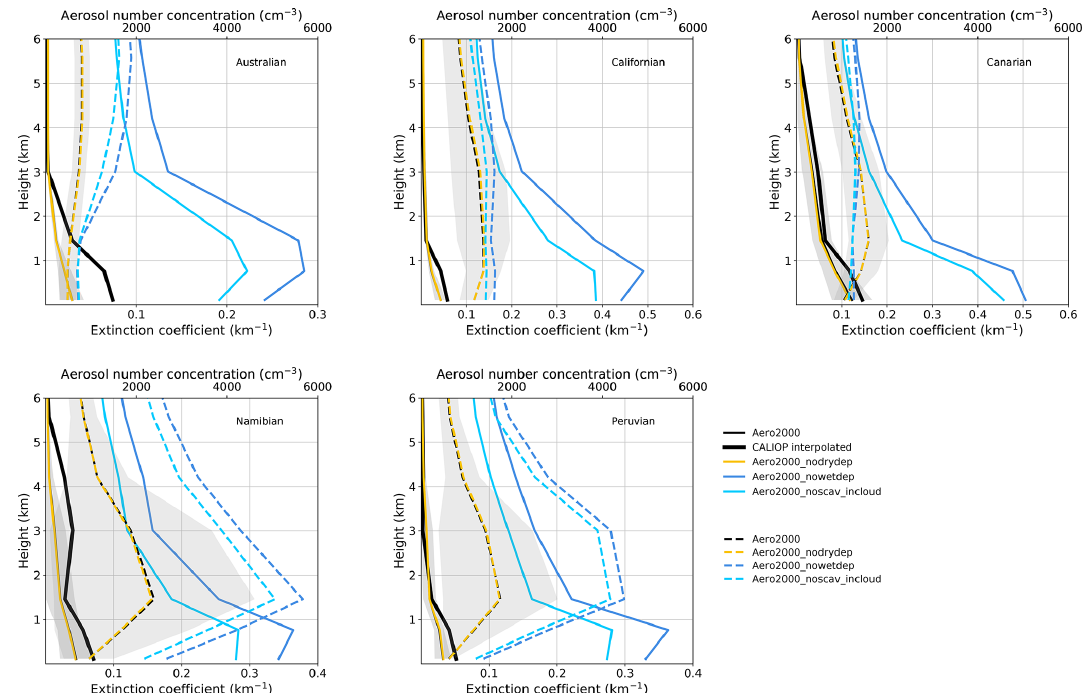
Figure 6. Vertical distribution of the aerosol extinction coefficient (km − 1 ; solid line) and aerosol number concentration (cm − 3 ; dashed line) for the Australian, Californian, Canarian, Namibian, and Peruvian regions for the model control simulation and sensitivity experiments in the category deposition. The SD of the model control simulation is indicated as a grey shaded